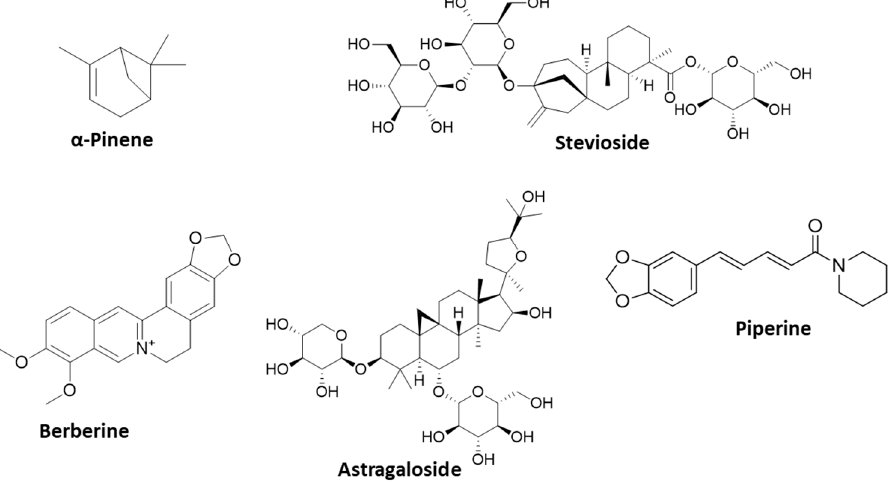
Figure 2. Chemical structures of potential phytoconstituents of pharmacological importance in antiglycation and antihyperglycemic effects.